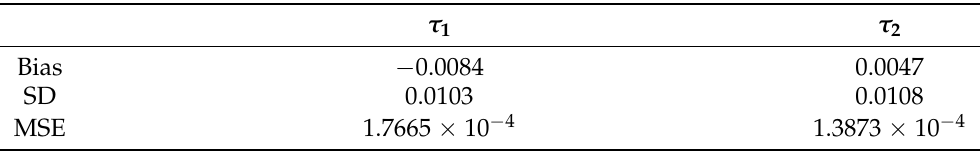
Table 6. Bias, SD and MSE according to the parameter τ for GNFPLSIM with the logistic link function and n =